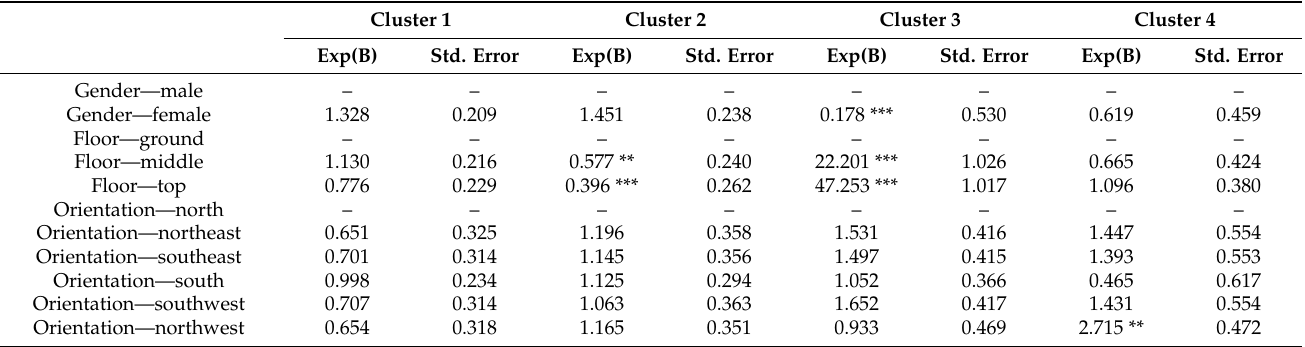
Table 1. Multi-nominal logistic regression analysis